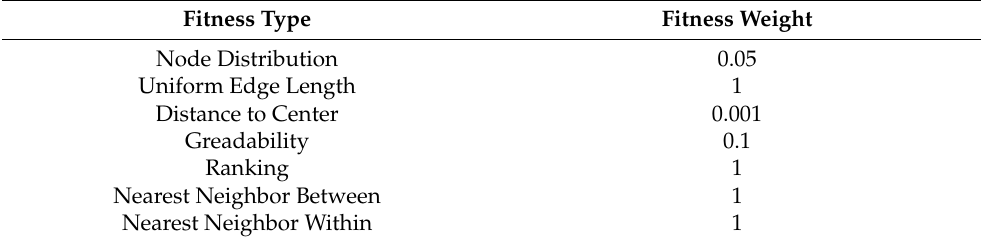
Table 4. Fitness weight